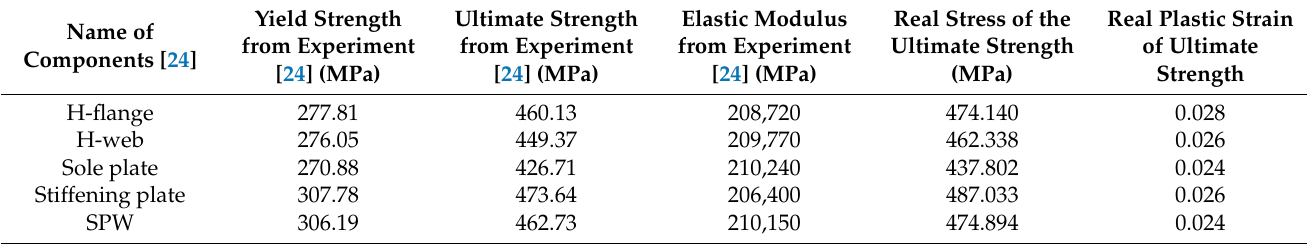
Figure 3. Finite element modeling (FEM) for verification: ( a ) whole model; ( b ) bolts on the column foot; ( c ) bolts on the steel plate and the base. Table 1. Constitutive relationship of steel in FEM model for